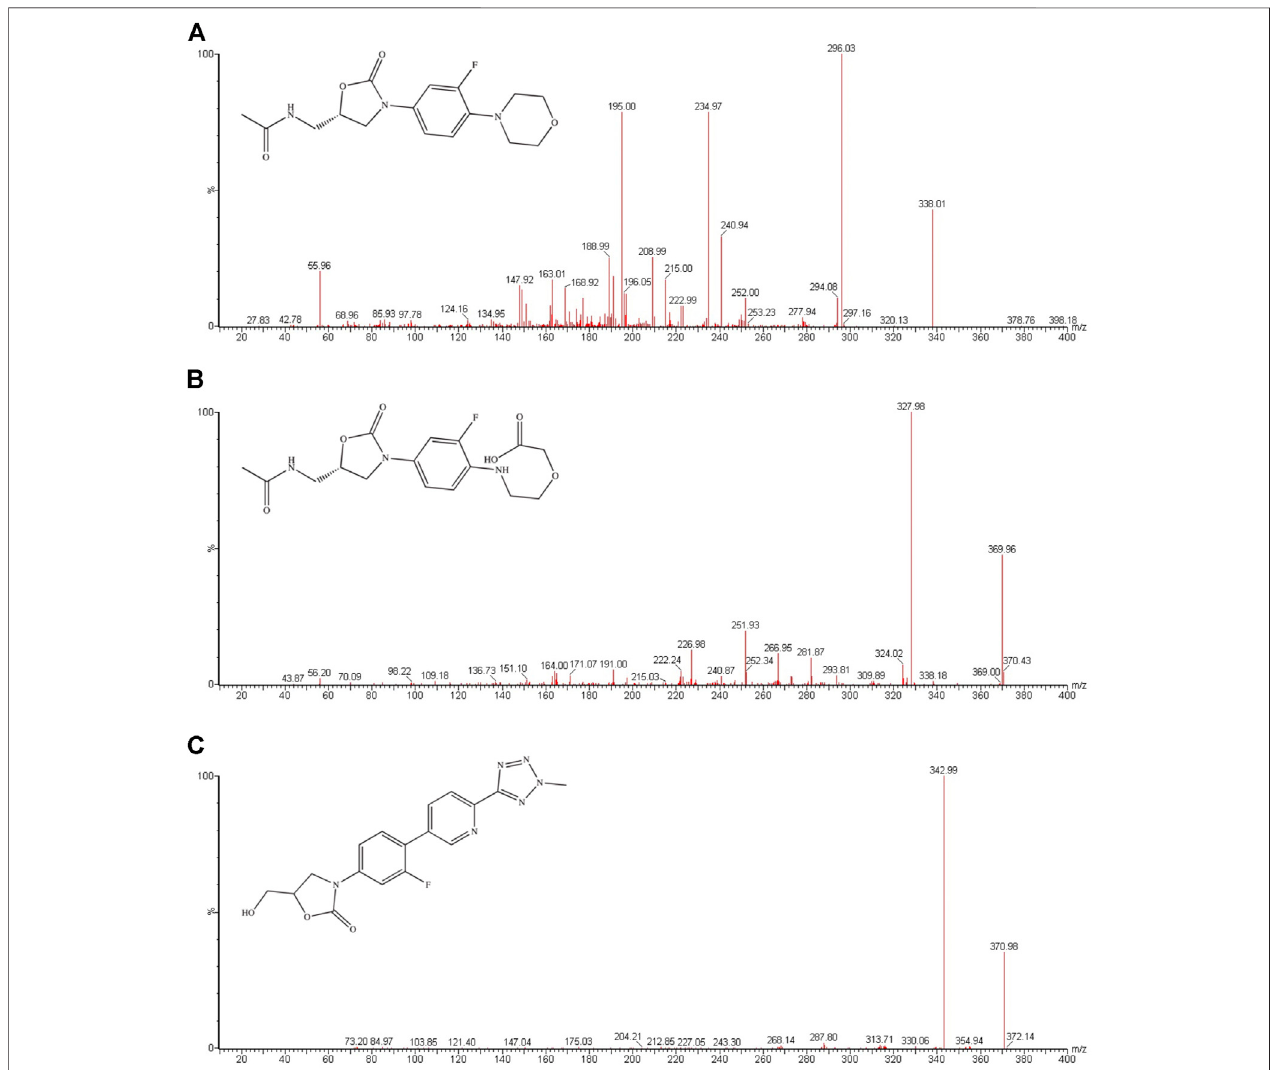
FIGURE 1 | Mass spectra of linezolid (A) , PNU-142300 (B) and tedizolid (IS, (C) in this